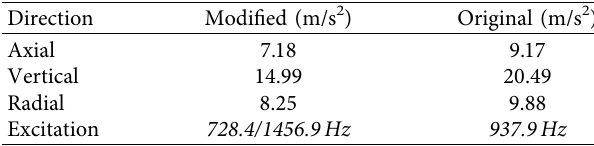
Figure 7: Axial acceleration of the modified model.